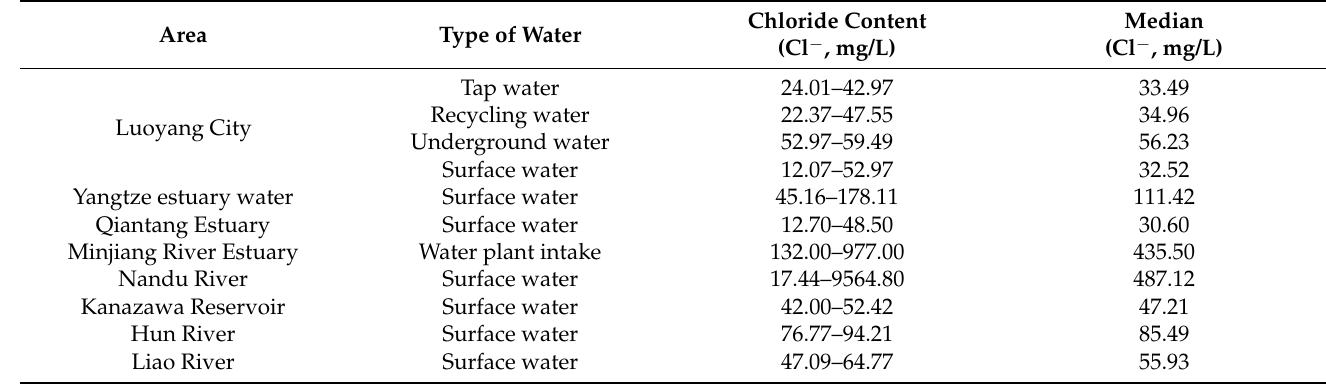
Table 2. Chloride content levels in the water bodies of some watershed areas in